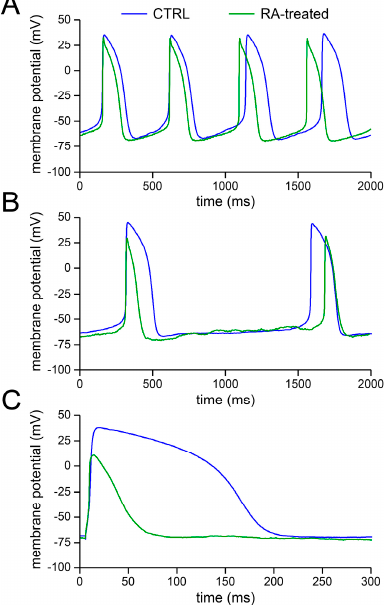
Figure 1. Superimposed action potentials of control (CTRL) and retinoic acid-treated (RA-treated) human induced pluripotent stem cell-derived cardiomyocytes (hiPSC-CMs). ( A , B ) Typical action potentials of ( A ) fast beating and ( B ) slowly beating CTRL and retinoic acid (RA)-treated hiPSC-CMs. ( C ) Typical action potentials during overdrive stimulation at 1 Hz. Note the expanded time scale. slowly beating groups. RA treatment resulted in a shorter action potential duration at 20% repolarisation (APD 20 ) and lower AP plateau in both fast and slowly beating hiPSC-CMs. These